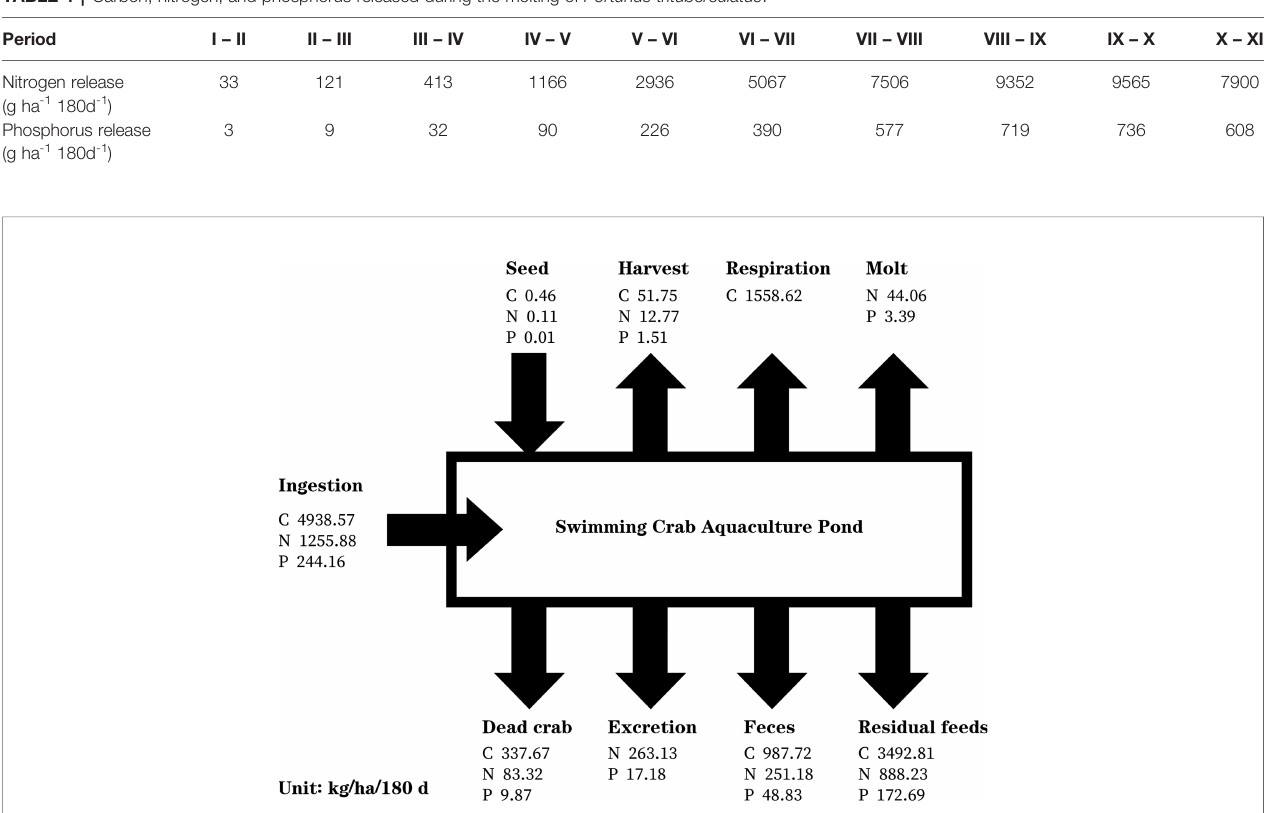
FIGURE 3 | Carbon (C), nitrogen (N), and phosphorus (P) budgets associated with Portunus trituberculatus aquaculture over the six months rearing